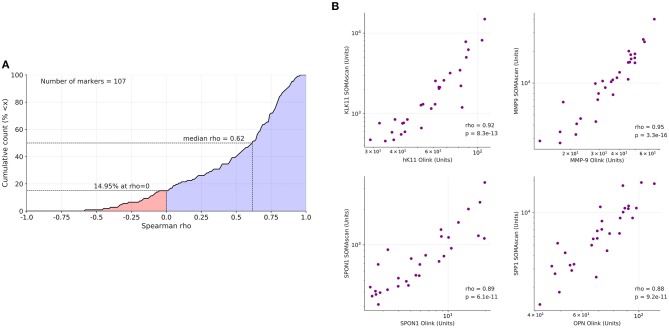
Correlation of PEA with SOMAscan data. (A) Data for 107 markers were analyzed to calculate the cumulative distribution of Spearman correlation coefficients (ρ) between PEA and SOMAscan signal intensities, yielding a median value of ρ = 0.62. The analysis was carried out with 20 OC-plasma and 10 N-plasma samples. The light blue area indicates positive correlations (85.05% of all instances), light red indicates negative correlations (14.95%). (B) Dot plots showing highly significant positive correlations of PEA and SOMAscan data (n = 30) for KLK11, MMP9, SPON1, and SPP1/OPN.